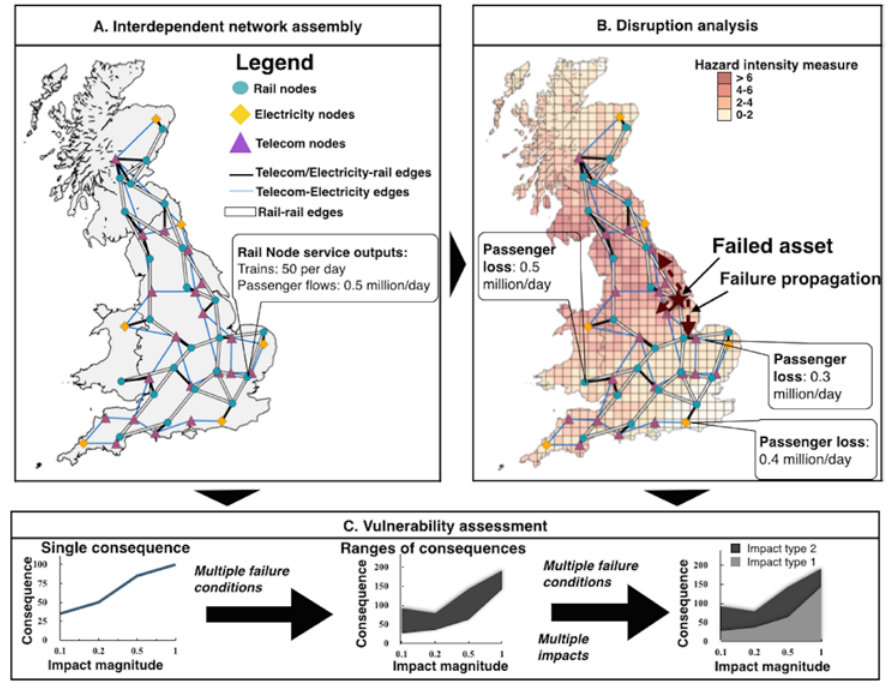
Figure 1. Vulnerability assessment framework for national infrastructure